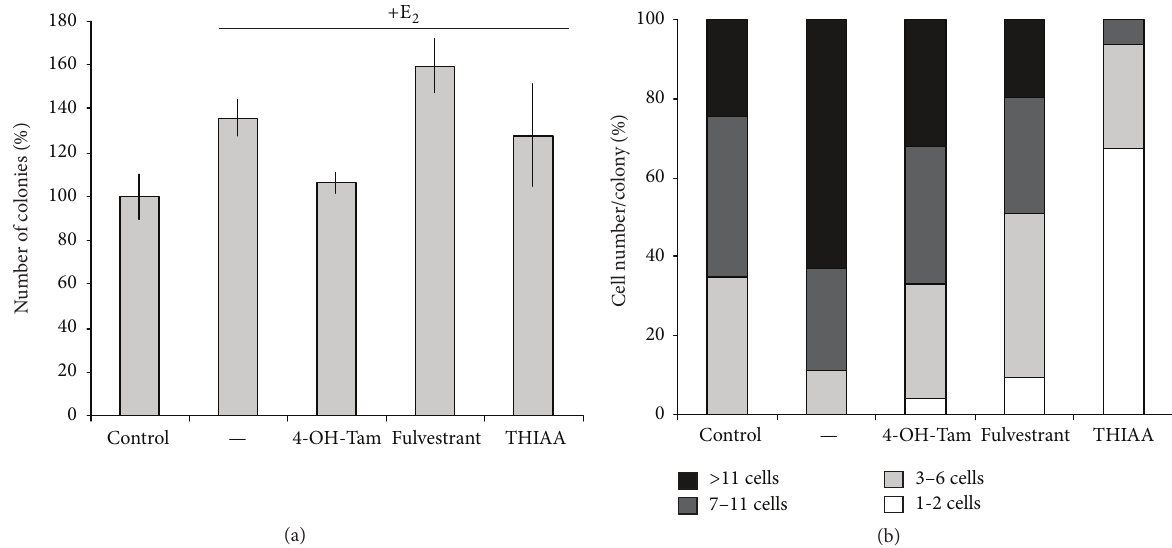
Figure 6: Effect of THIAA on E 2 -stimulated MCF-7 cell clonogenicity in steroid-free culture medium. Cells were seeded in Petri dishes at low concentration. Cells were grown during 72 h in the absence (control) or presence of E 2 at 10 −9 M with or without antiestrogens at 10 −6 M or THIAA at 0.01%. Number of colonies (a) and number of cells per colony (b) were counted. For the later, data were subdivided into 4 classes (1-2, 3–6, 7–11, and more than 11 cells) according to a quartile calculation.